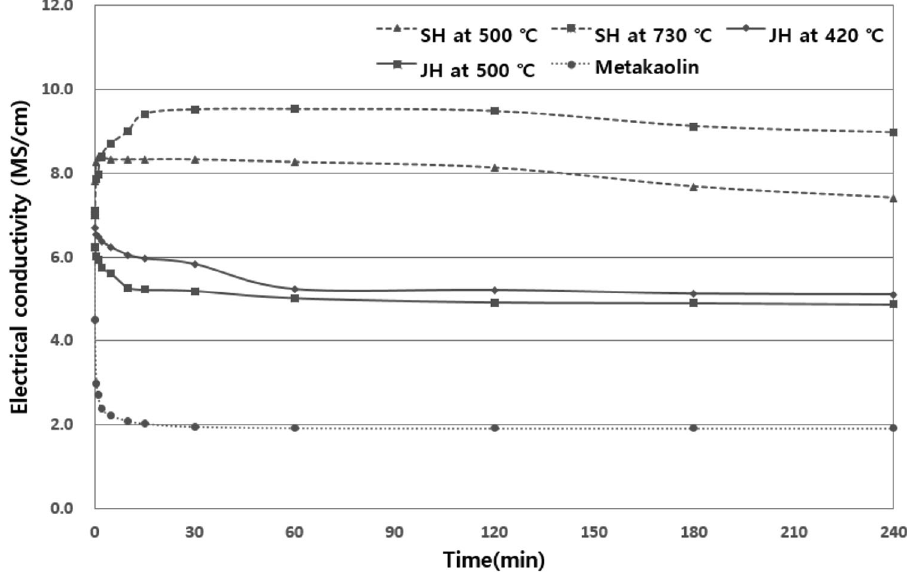
Fig. 7 Electrical conductivity of metakaolin and heat treated dredged sea